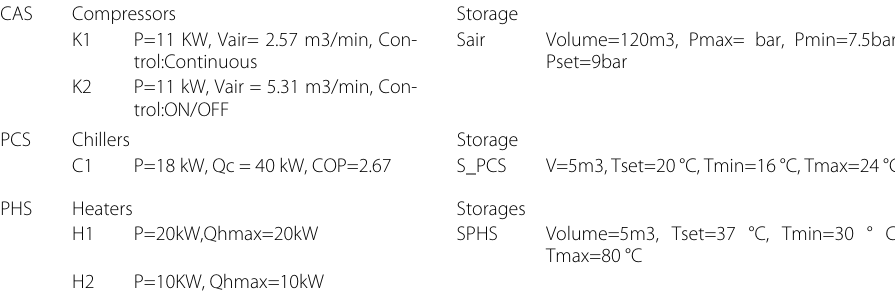
Table 8 Details of the technical units inside TBS in